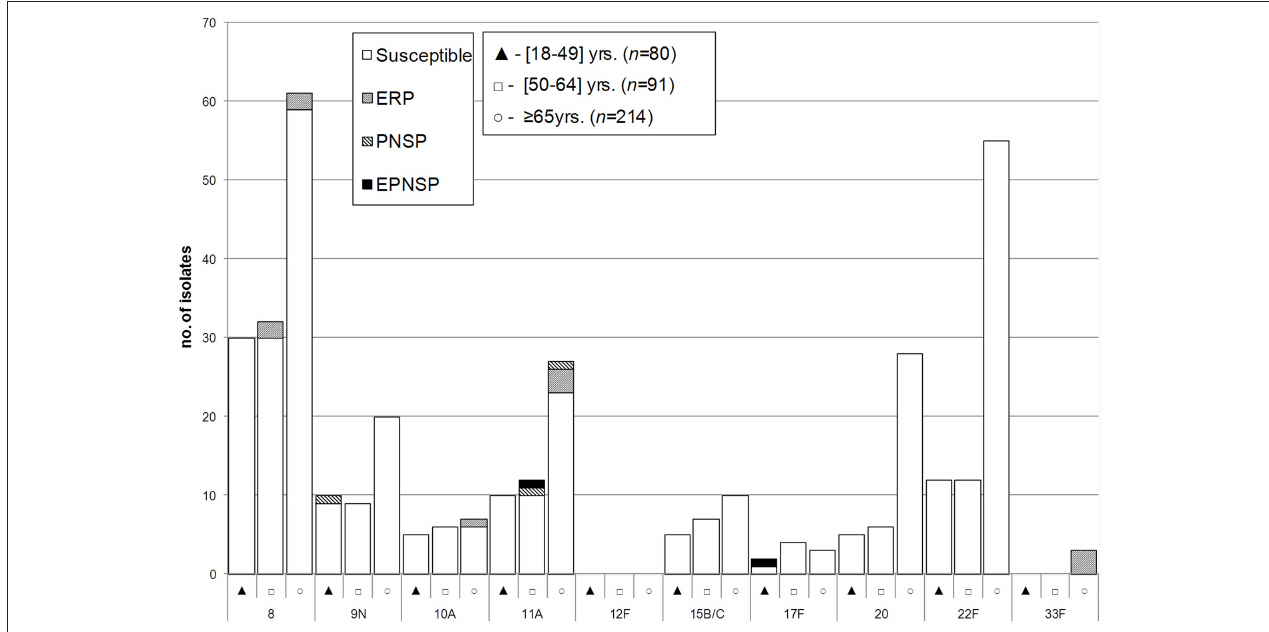
FIGURE 2 | Isolates expressing serotypes present in PPV23 but not included in conjugate vaccines causing invasive pneumococcal disease in adult patients ( ≥ 18 years) in Portugal, 2012–2014. See legend of Figure 1 . Out of the 11 serotypes present in PPV23 but absent from PCV13, serotype 2 was not found in our